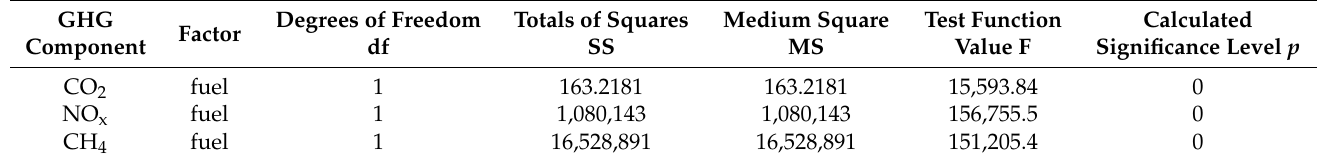
Table 6. ANOVA results for the emission levels (volumetric shares) of GHG components by fuel (rapeseed straw pellets, wood pellets).